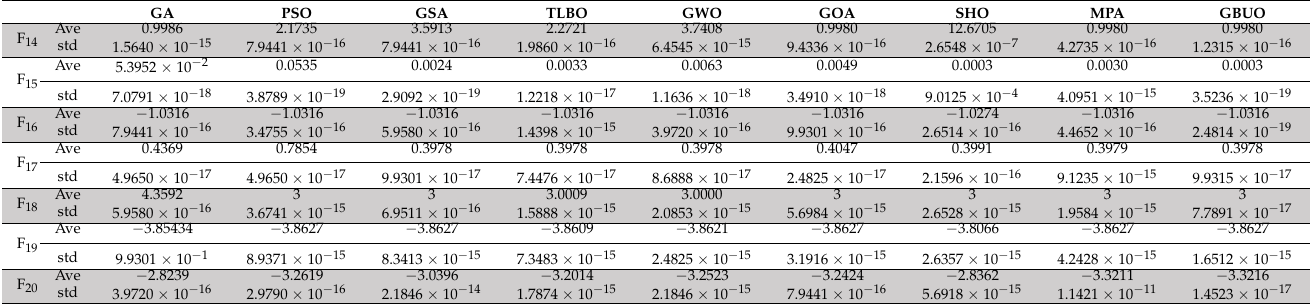
Table 5. Results of applying optimization algorithms on fixed-dimension multimodal objective functions.